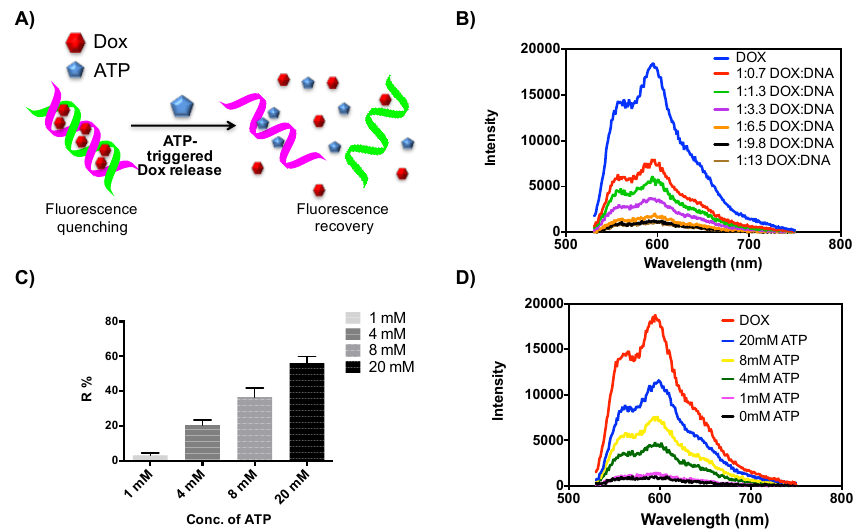
Figure 1. ( A ) Schematic illustration of the ATP-triggered release of Dox from the ATP-binding aptamer incorporated DNA scaffold. ( B ) The fluorescence spectra of Dox (1 µ g/mL) with increasing mass ratios of the DNA scaffold. ( C ) The percentage of Dox fluorescence recovery from the Dox-DNA in the presence of different concentrations of ATP (1, 4, 8, 20 mM). Error bars represent SD ( n = 3). ( D ) the fluorescence spectra of Dox-DNA (1 µ g/mL) at the mass ratio of Dox to DNA of 1:10 in the presence of different concentrations of ATP (1, 4, 8, 20